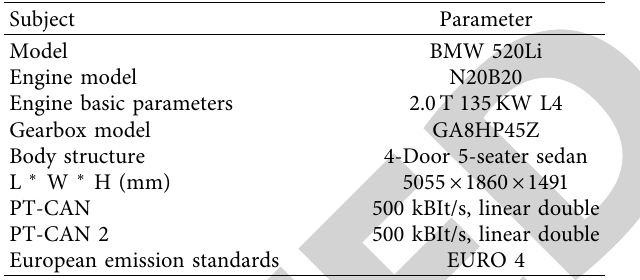
Table 1: Main relevant technical parameters of the F18